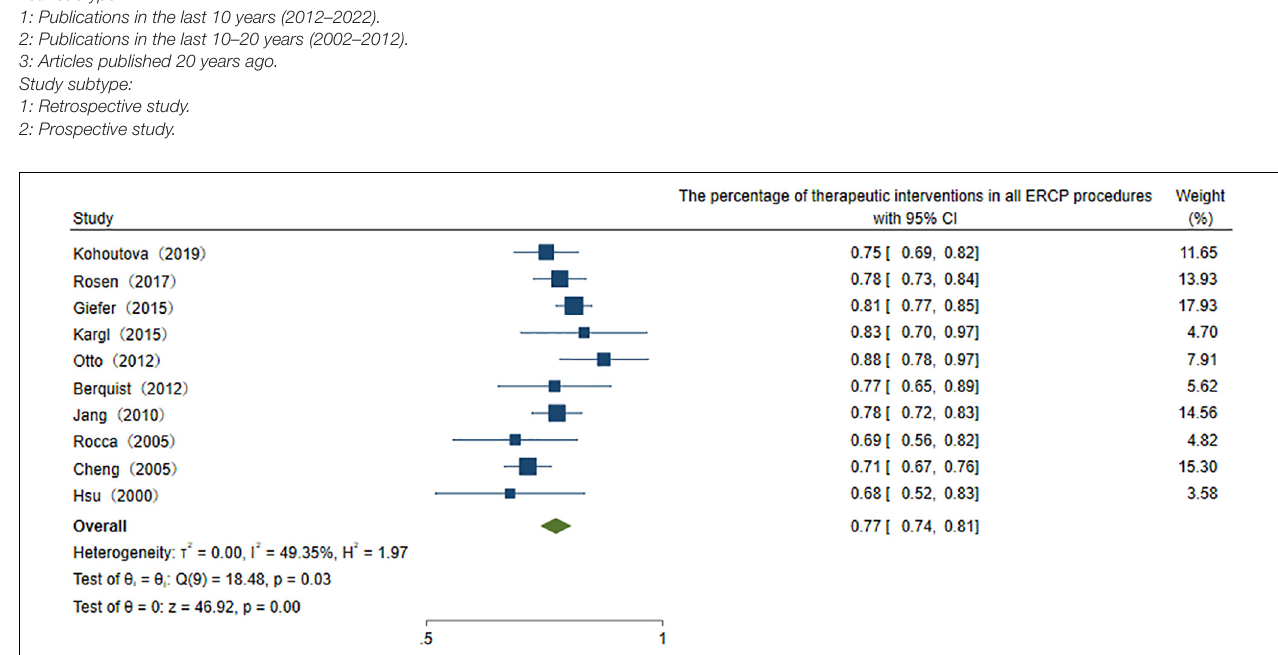
(ST), stone extraction/removal, bougienage/balloon dilation was found to be, respectively, 46% (95% CI 39–53%), I 2 = 56.5%, the forest